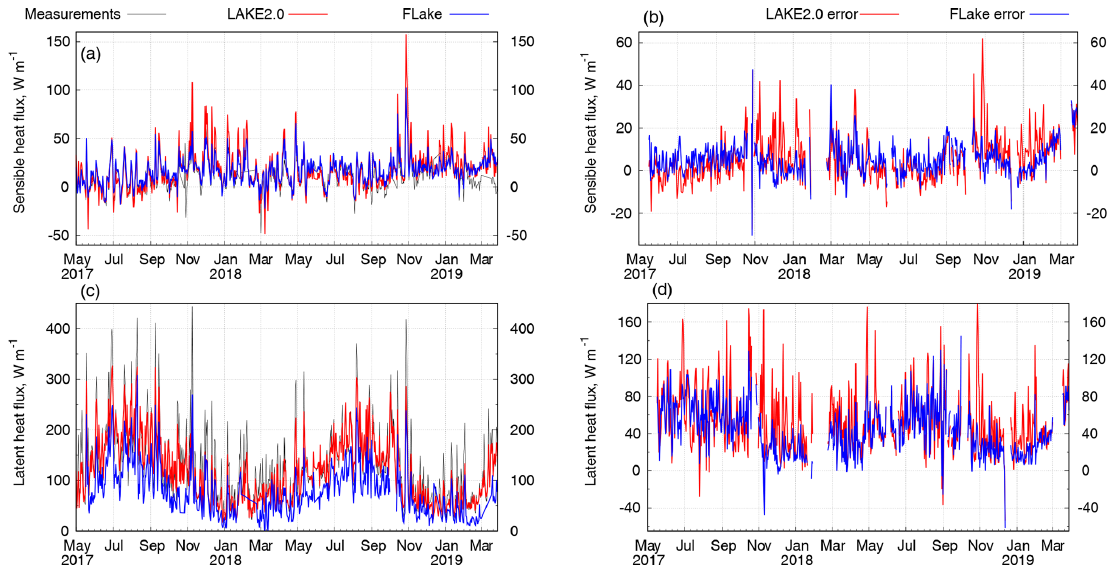
Figure 7. Daily averaged sensible (a) and latent (c) heat fluxes with corresponding errors (b and d) . Black curve represents the measured values, the red curve shows LAKE 2.0 results, and the blue curve shows FLAKE results. Table 4. Chlorophyll a measurements at the Alqueva reservoir.